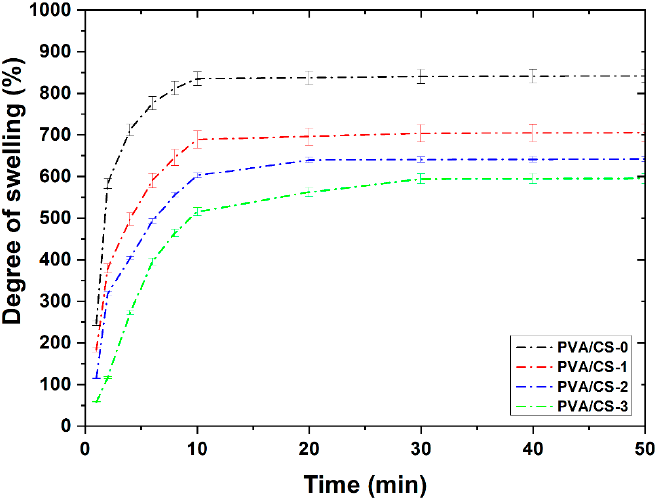
Figure 5. Swelling degree of PVA/CS